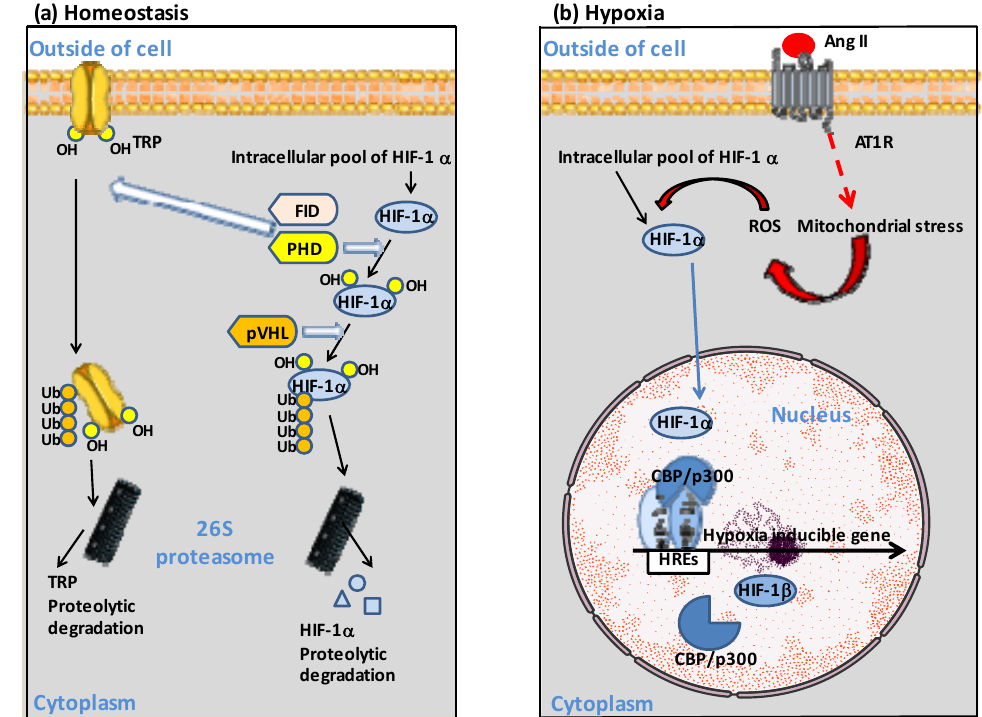
Figure 2. Schematic diagram illustrating the dual regulation of HIF ‐ 1 α . ( a ) At normal O 2 concen ‐ tration, HIF ‐ 1 α is hydroxylated by the prolyl hydroxylase (PHD). The ubiquitin ligase VHL targets HIF ‐ 1 α‐ OH for polyubiquitinylation and proteosomal degradation. Similarly, hydroxylation of the transient receptor potential channel (TRP) by PHD, and asparaginyl hydroxylase FIH targeting TRP ‐ OH for ubiquitinylation and proteosomal degradation, contribute to homeostasis. ( b ) Ang II can contribute to hypoxia through binding to AT1R, which initiates signaling events including ac ‐ tivation of reactive oxygen species (ROS) by mitochondria. Under hypoxia, HIF ‐ 1 α translocates to the cell nucleus where it forms heterodimers with the HIF ‐β subunit and binds to the hypoxia re ‐ sponse element (HRE) in the promoter of hypoxia ‐ inducible genes, recruiting histone acetyltrans ‐ ferases CREB Binding Protein (CBP)/p300 to modulate hypoxia ‐ inducible genes expression. For more details, see reference [65].